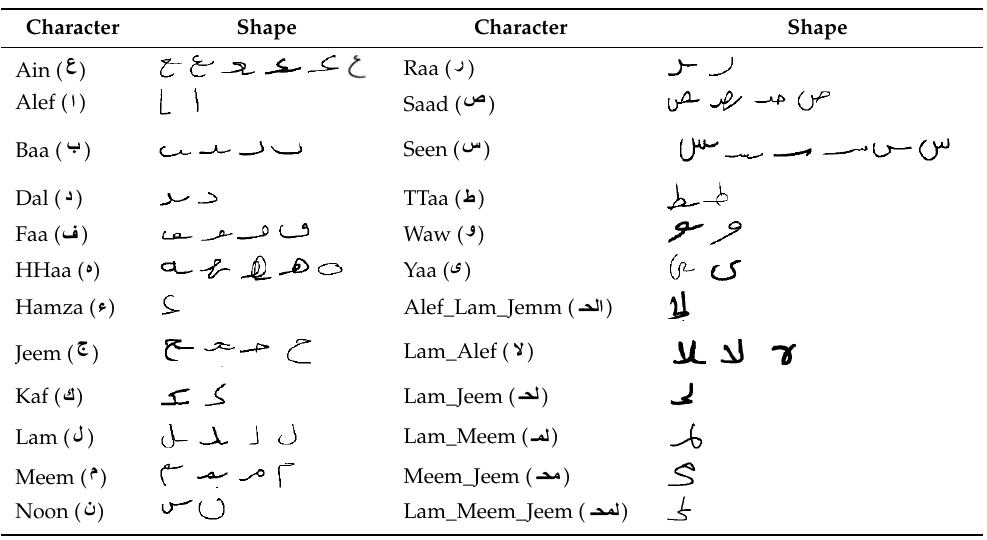
Table 7. Experimental results on the HACDB database.